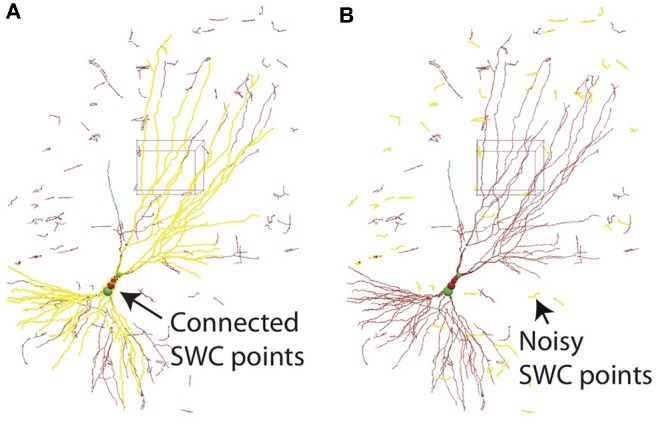
(A) In 3D View, selecting one SWC point and pressing h-5 selects all SWC points connected to the selected. This operation is useful for detecting broken connections. (B) Pressing h-7 selects all branches with total length smaller than a chosen threshold. This operation is useful for deleting noise.